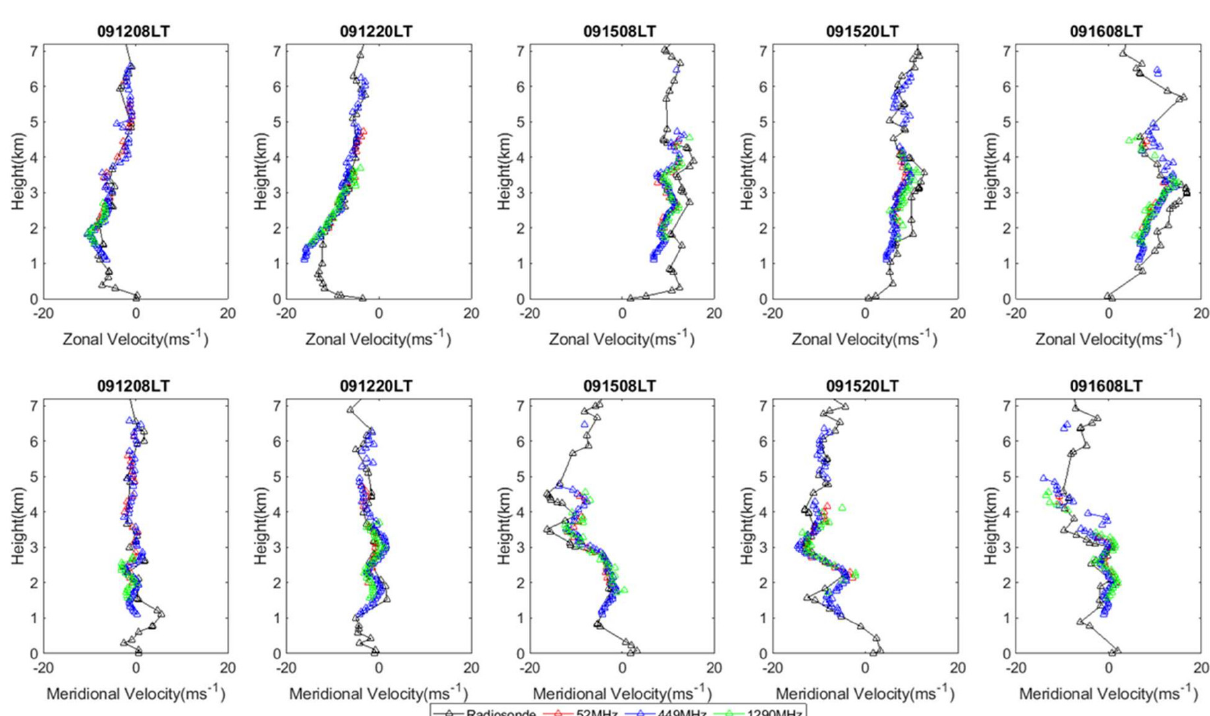
Figure 7. Same as Figure 6, but for zonal ( upper ) and meridional ( lower ) wind velocities.